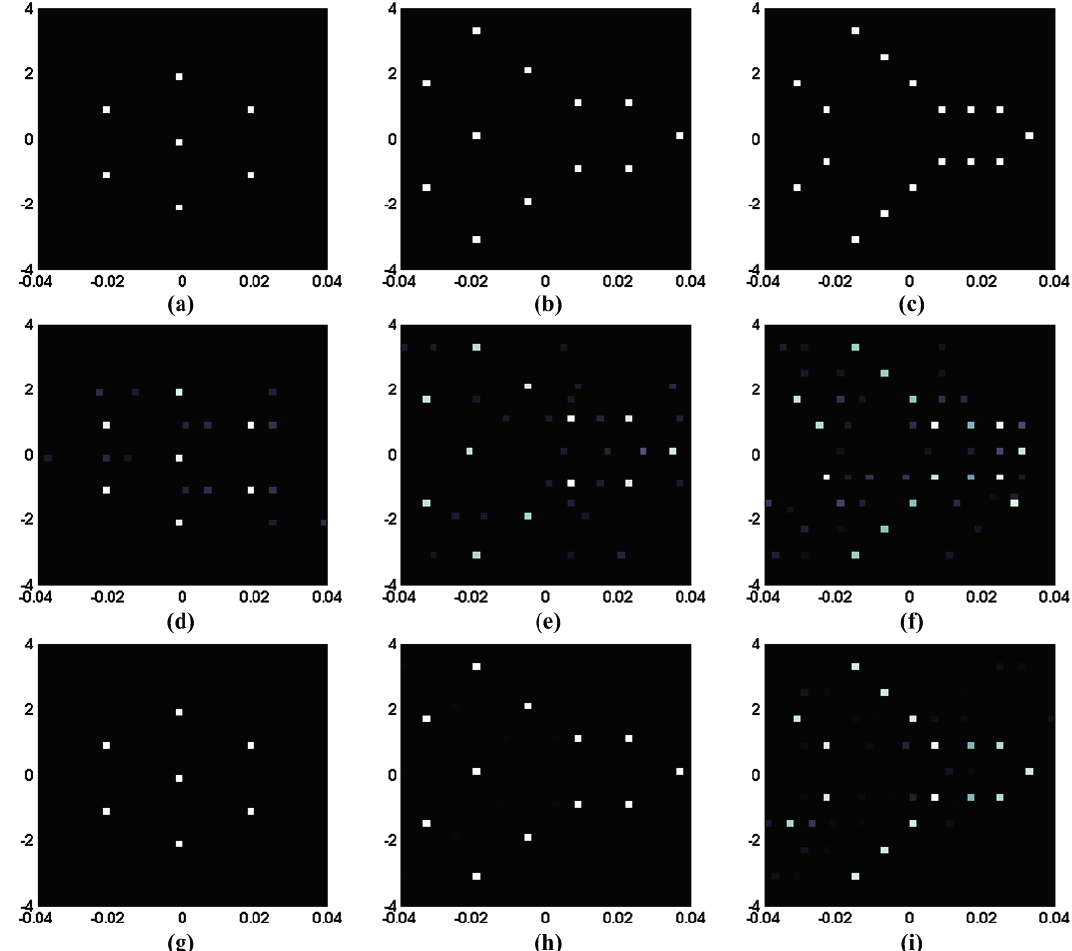
Figure 6. RCI results for different target scenes. ( a – c ) Three different target scenes; ( d – f ) Imaging results of OMP for the three target scenes; ( g – i ) Imaging results of